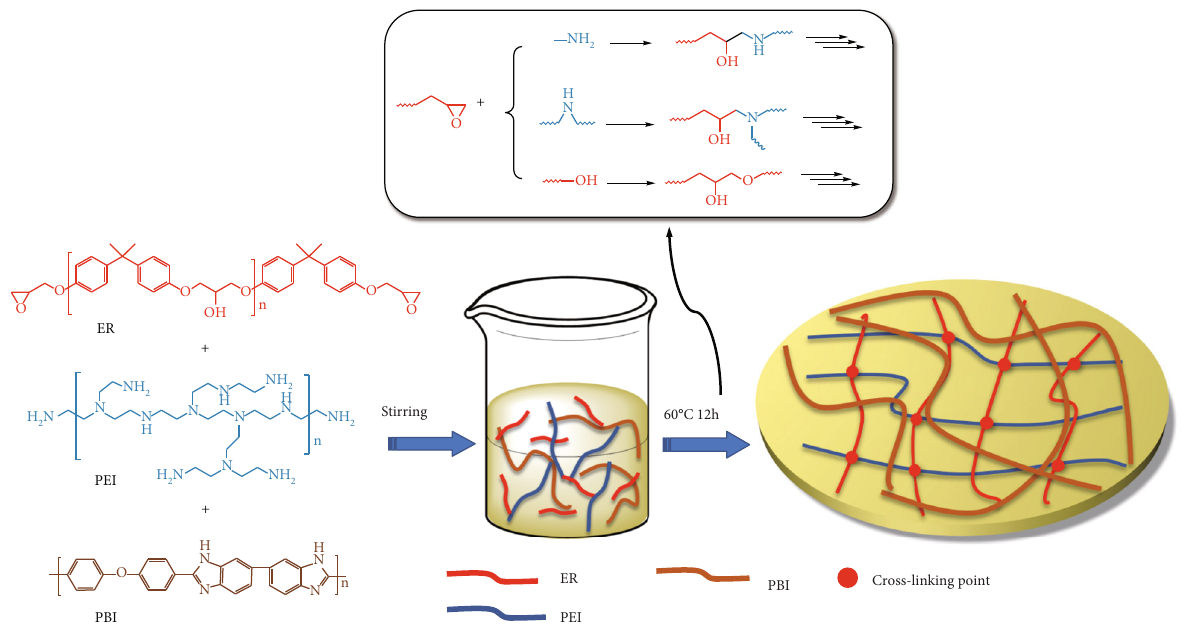
Figure 1: In situ step-growth polymerization of polyethylenimine (PEI) and epoxy resin (ER) in the presence of polybenzimidazole (PBI) to form a PEI-ER/PBI semi-IPN membrane, where PBI and PEI-ER crosslinked networks form a semi-interpenetrating network structure.